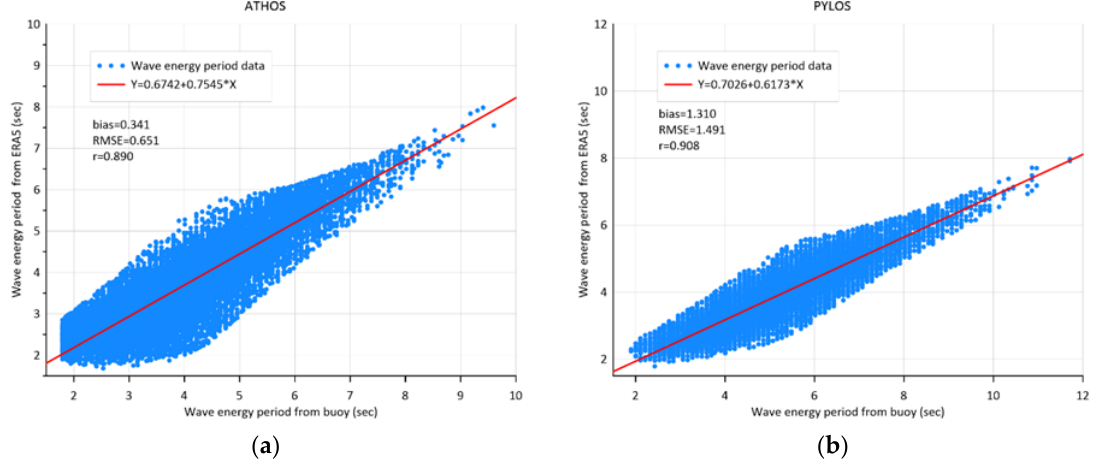
Figure 3. Scatter plots of 𝑇 𝑒 obtained from buoy and ERA5 dataset for Athos ( a ) and Pylos ( b ).